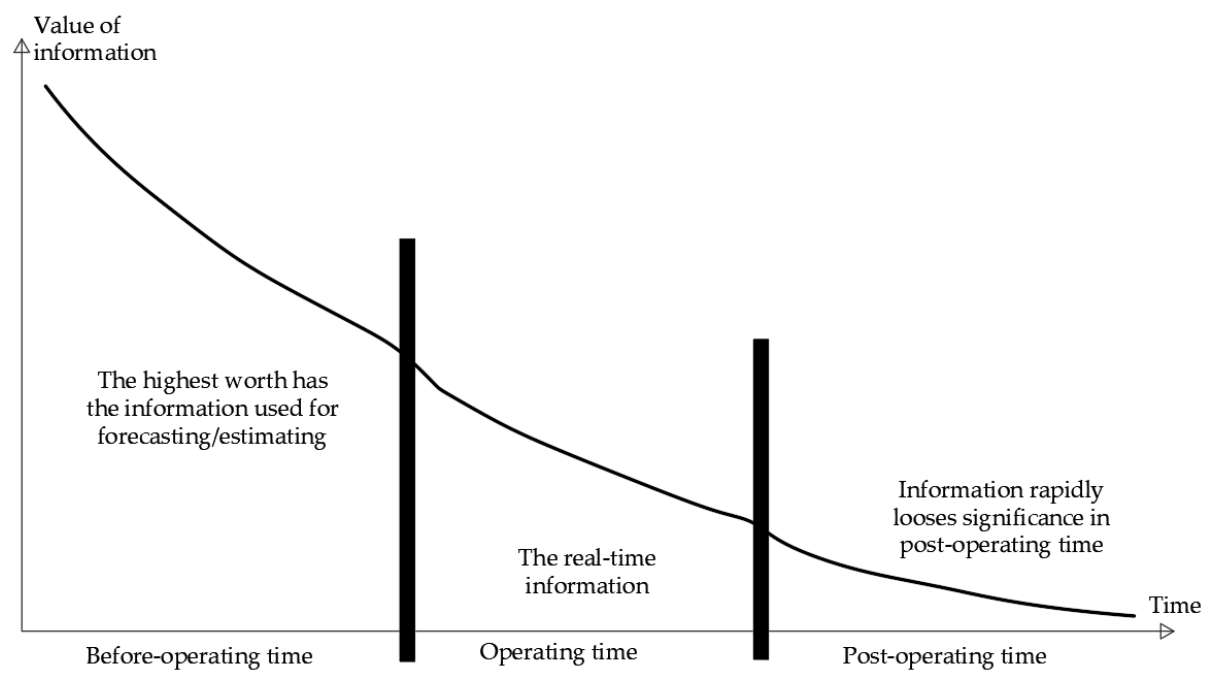
Figure 1. Value of information as a function of time, Reprinted with permission from ref. [14]. Copyright 1993 B. Đorđević .